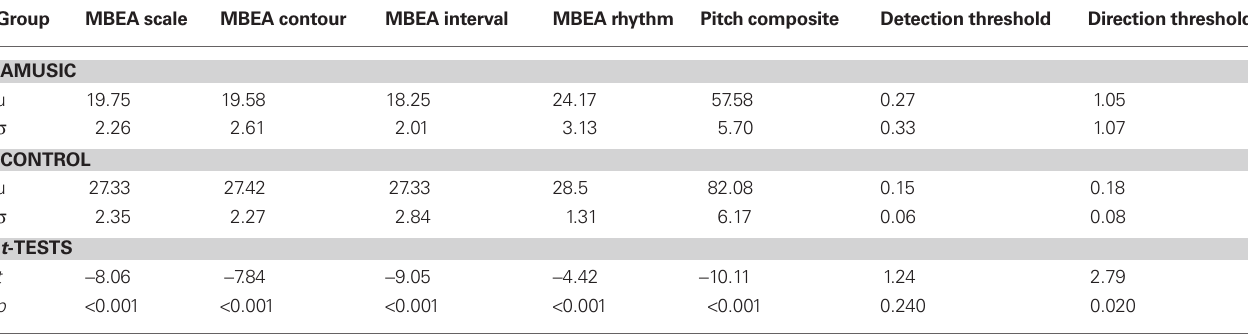
Table 2 | mean scores of the amusic and control groups on sub-tests of the montreal Battery for the evaluation of amusia (mBeA). A pitch composite score below the cut off of 65 out of 90 was considered to be diagnostic of